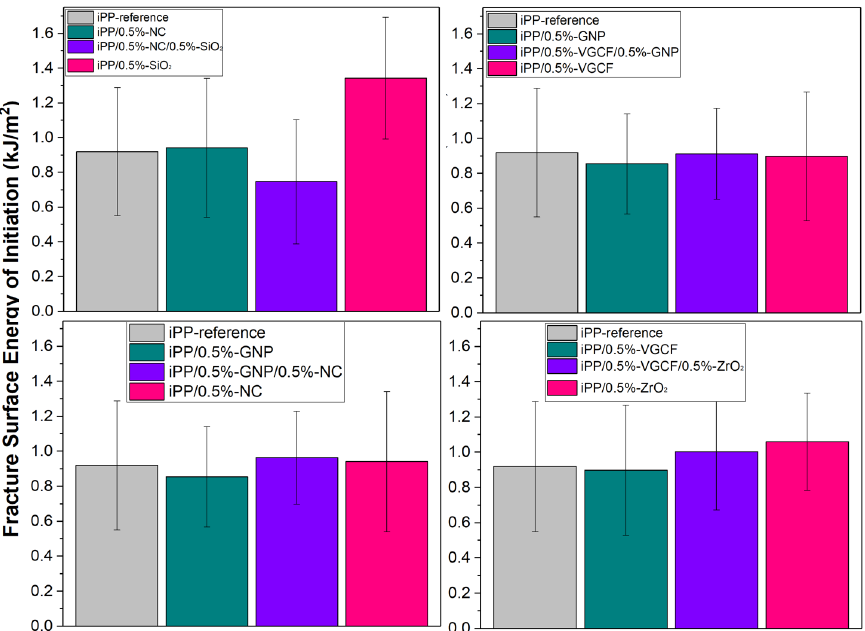
Figure 3. Fracture surface energies of initiation ( γ I ) for all the nanocomposites. Each value is an average of at least seven measurements, showing the average standard deviations.